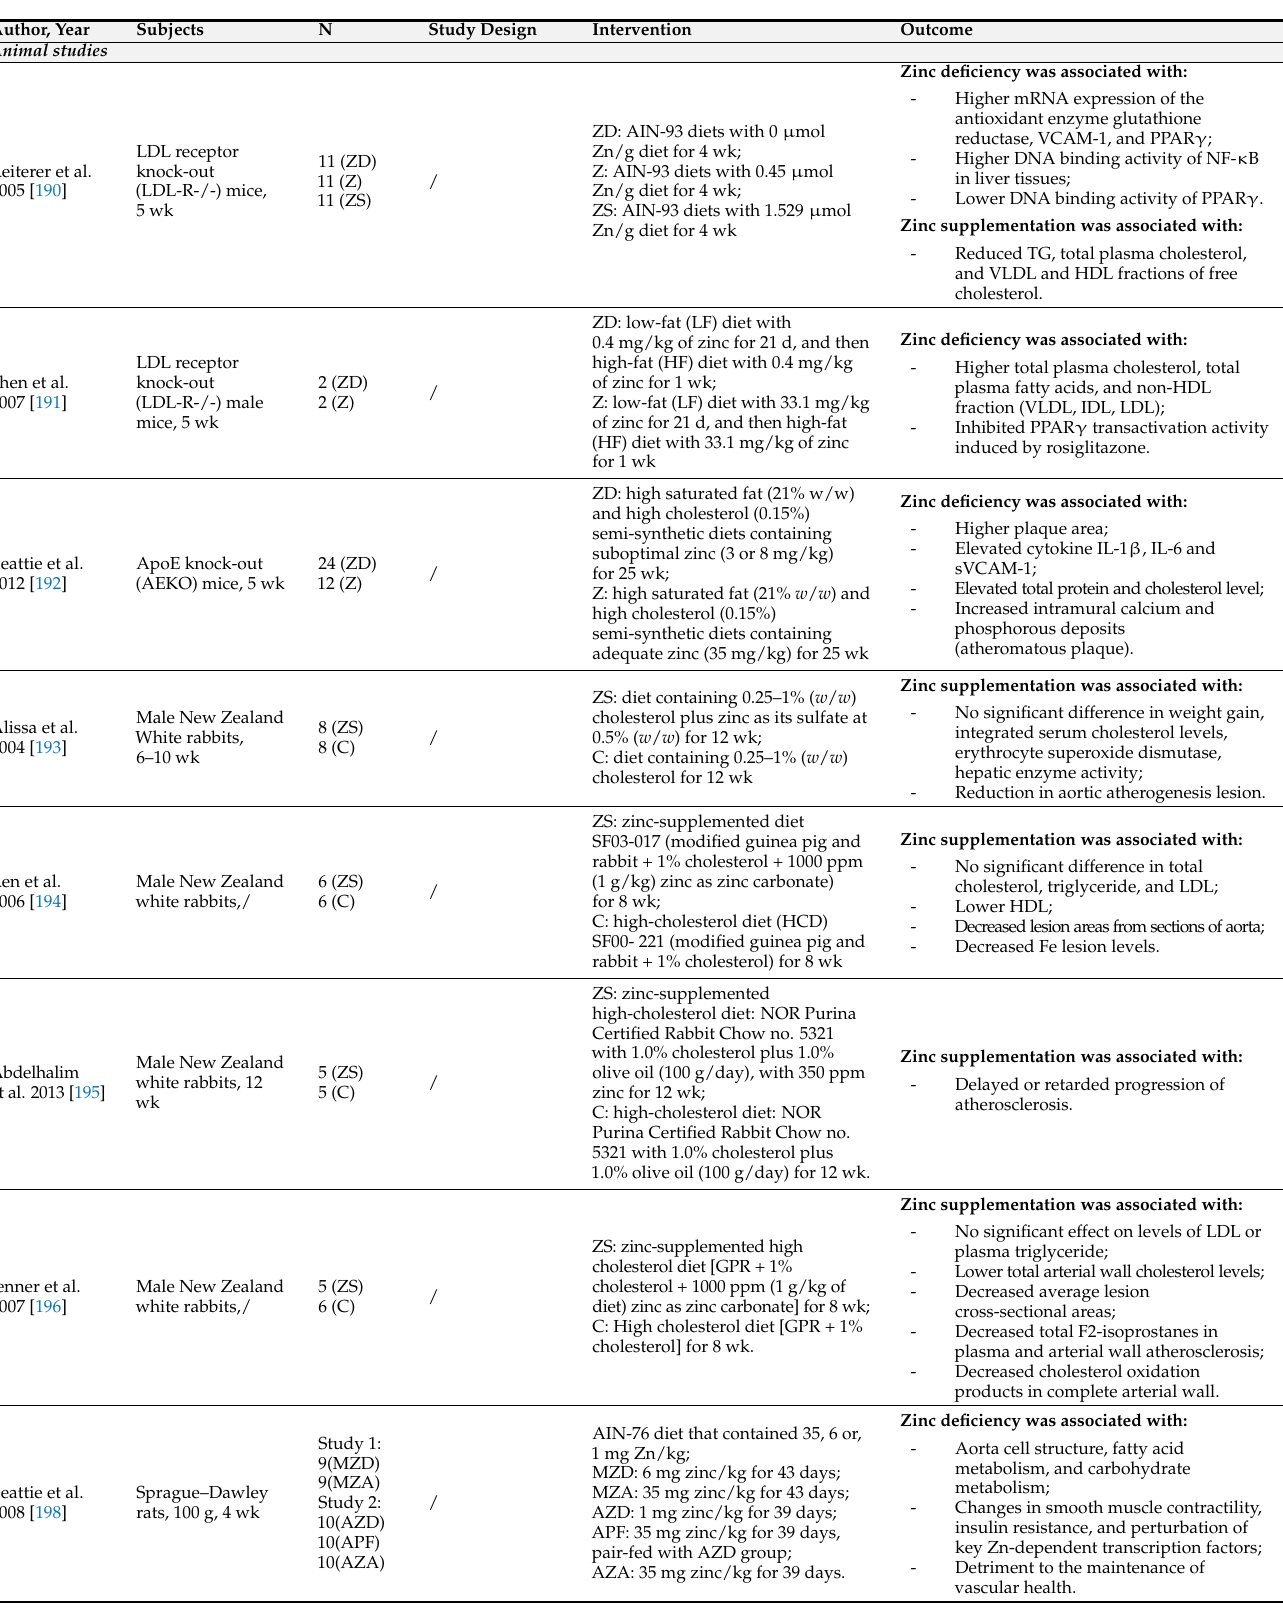
Table 1. Animal and human studies that report the effects of zin on